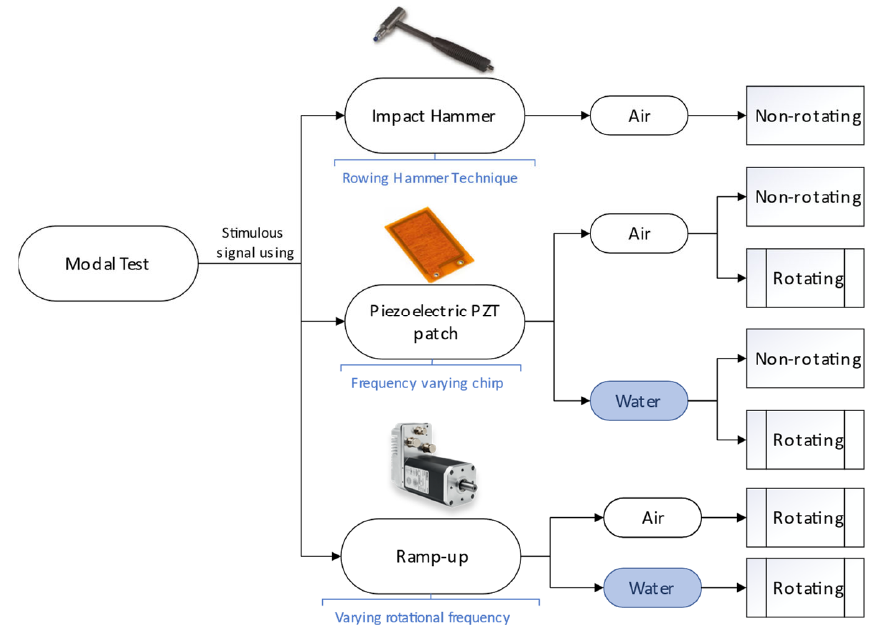
Figure 4. Scheme of the methodologies used to perform the experimental modal tests.